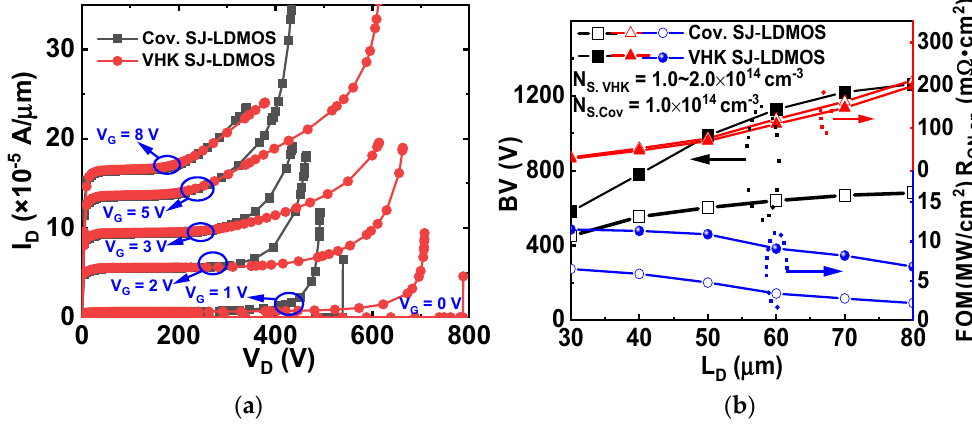
Figure 6. ( a ) Output characteristics for VHK SJ-LDMOS and conventional SJ-LDMOS, ( b ) dependences of BV, R ON,sp and FOM on L D for VHK SJ-LDMOS and conventional SJ-LDMOS.